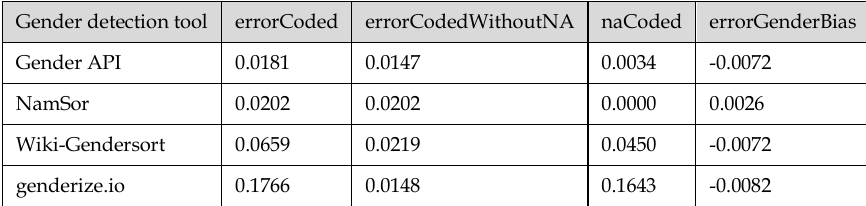
Table 4 Performance metrics for gender detection tools (n=6,131 physicians)